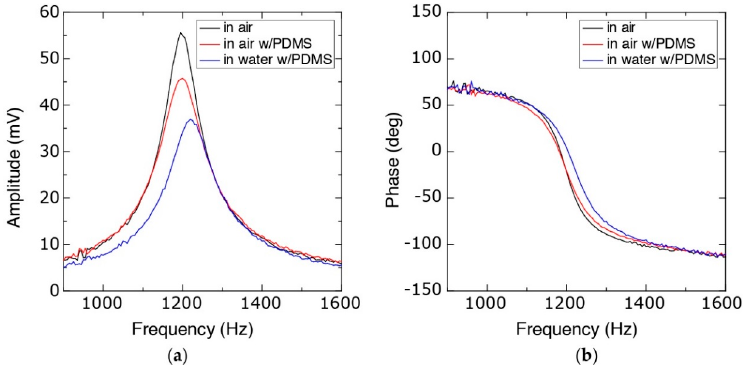
Figure 8. Frequency response of the device in different conditions showing ( a ) the amplitude and ( b ) the phase shift of the sensor readouts.